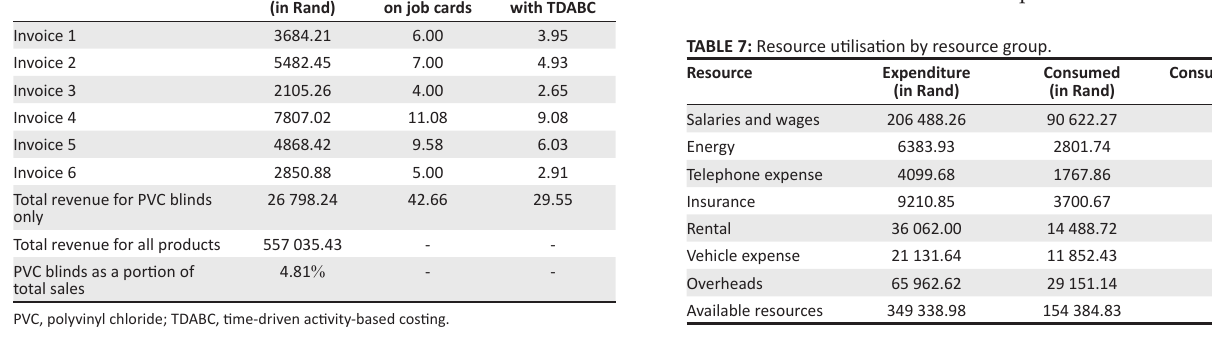
TABLE 5: Production hours stated on job cards compared to time-driven activity- based costing calculation.